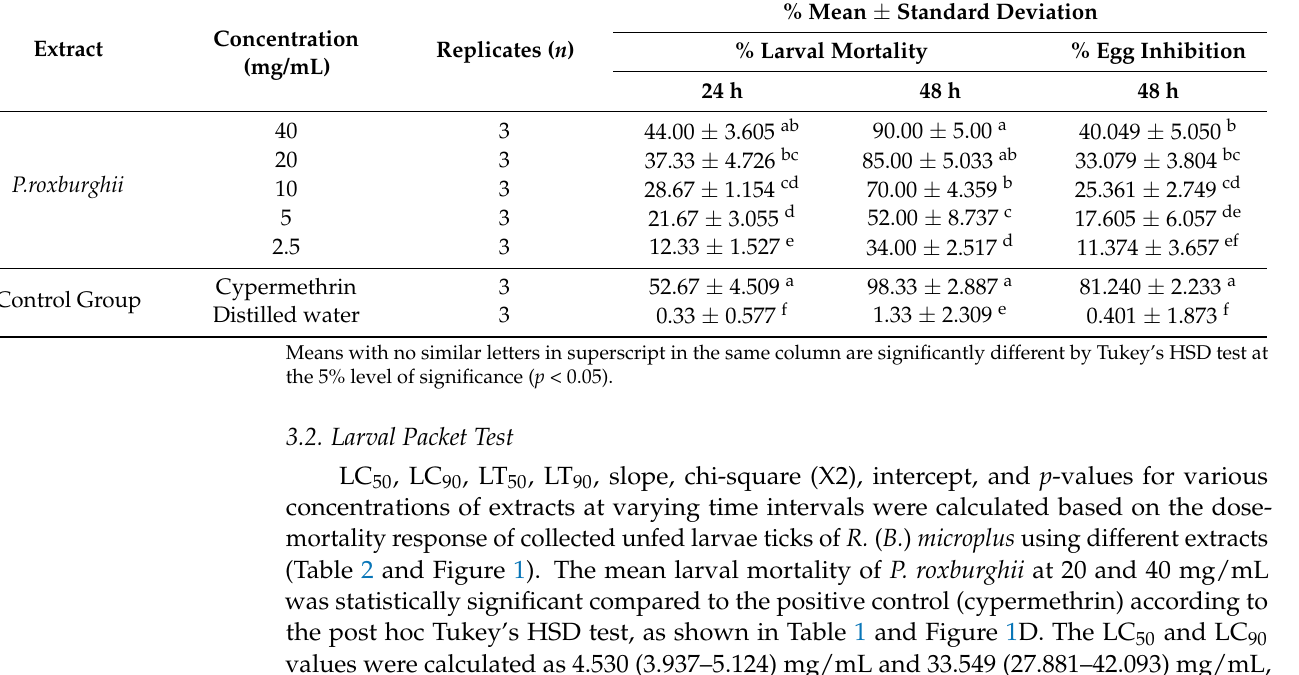
Table 1. The % mean values ± its standard deviation for different concentrations of Pinus roxburghii plant leaves extract on R. ( B. ) microplus larval mortality at 24 and 48 h as well as the inhibition of oviposition in adult female R. ( B. ) microplus